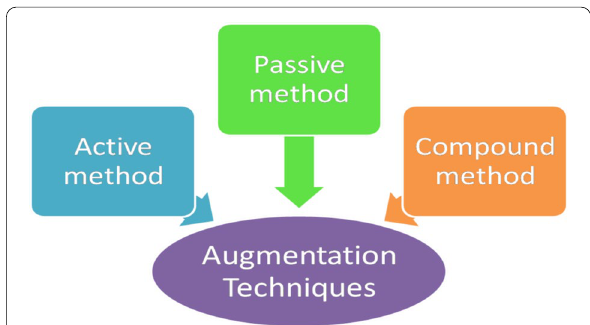
Fig. 1 Schematic representation of Thermal and Hydrodynamic boundary